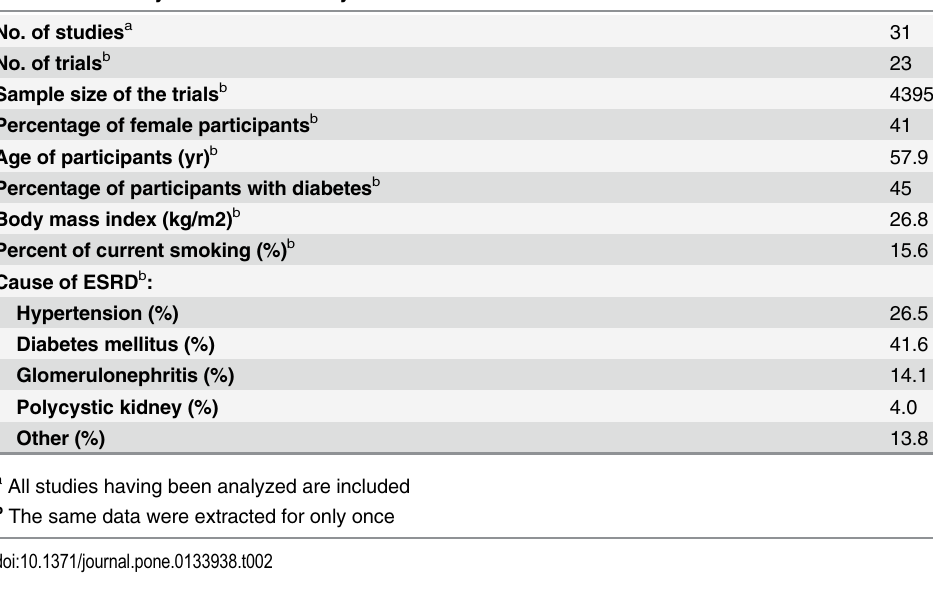
Table 2. Summary of the studies